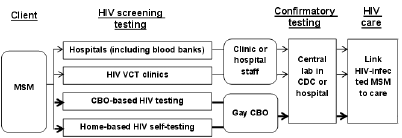
Figure 3. Linking HIV home testing MSM into public health programs among Chinese MSM through gay community based organization (CBO). CDC: center for disease control and prevention; VCT: voluntary counseling and